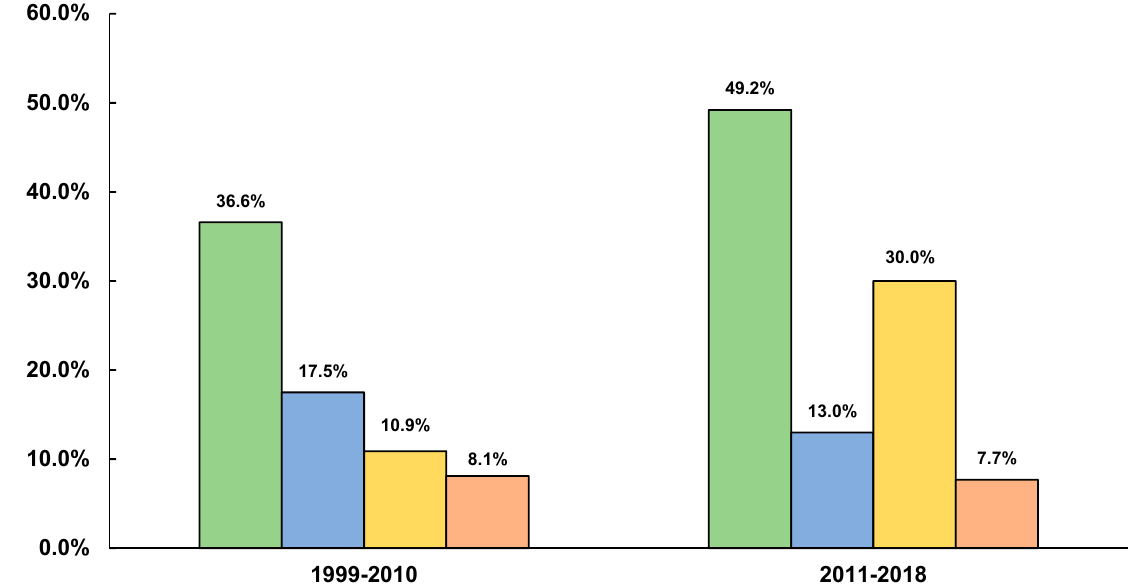
Figure 4. Anti-tuberculosis antibiotic resistance patterns in Bangladesh between 1999 and 2018.